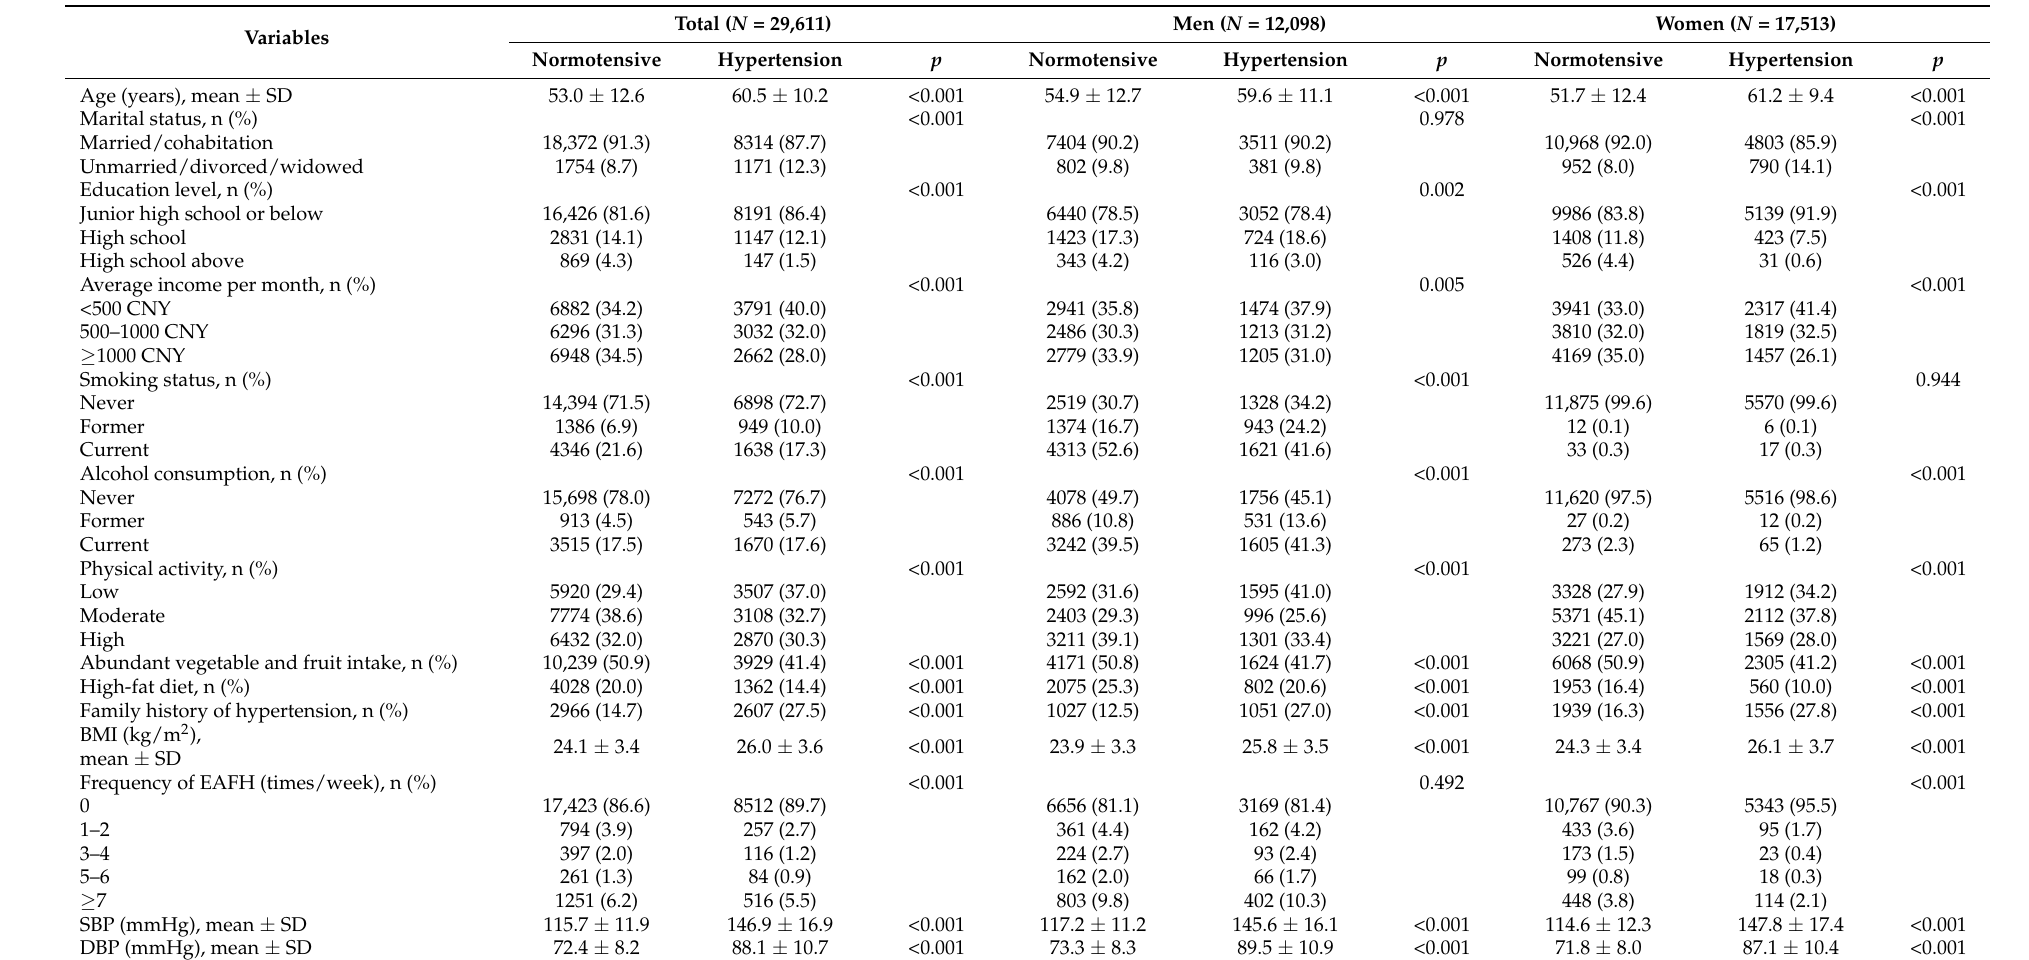
Table 1. The characteristics of participants by